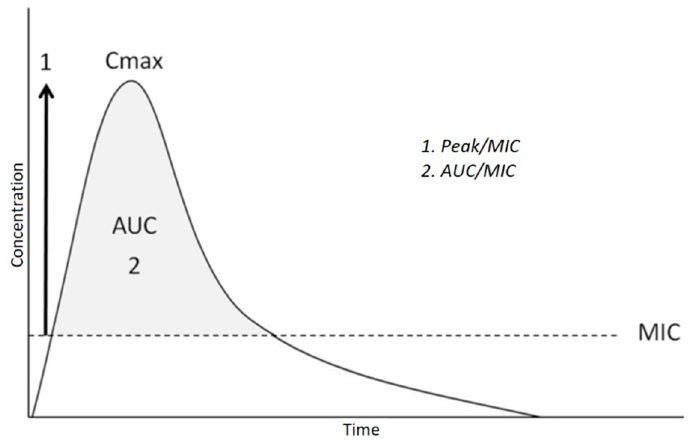
Figure 4. Kinetics of concentration-dependent drugs. The e ff ectiveness of the drug is linked to how high the absolute peak (Cmax) and the area under the curve is above the MIC